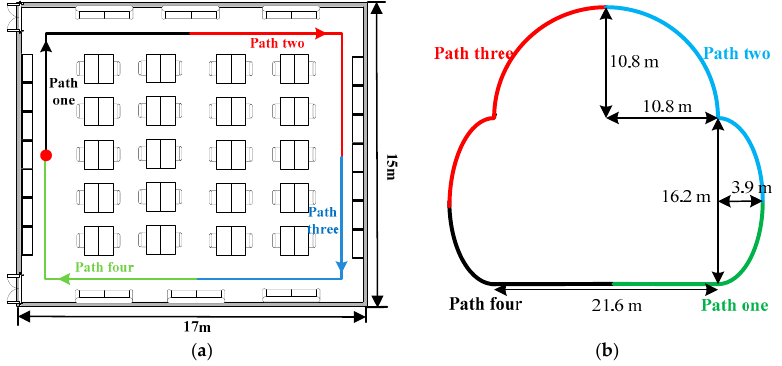
Figure 7. Test environment. ( a ) Environment 1: walking path includes four straight lines and is divided into four sub-paths indicated by different colors; ( b ) Environment 2: walking path includes one straight line, two symmetric parabolas, and a half circle, and is divided into four sub-paths by different colors.